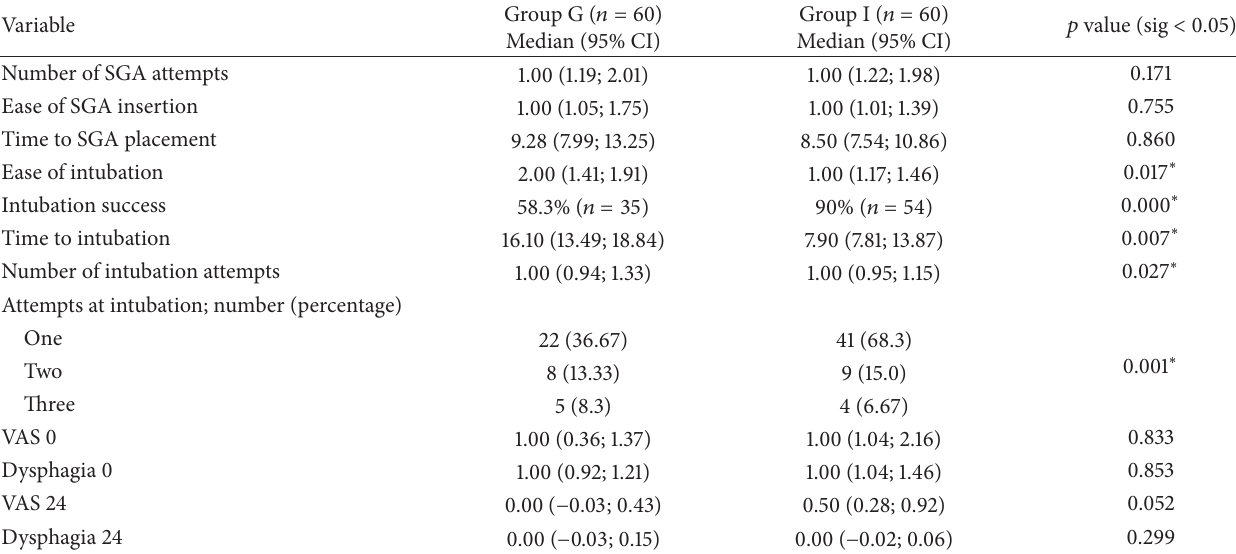
Table 2: Device insertion and intubation